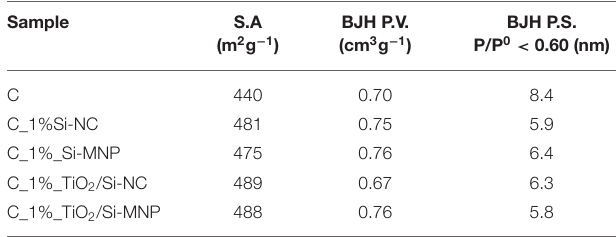
TABLE 4 | Surface area (S.A.), total pore volume (BJH P.V.), and pore size (BJH P.S.) of samples added with 0.1% of nanoparticles.